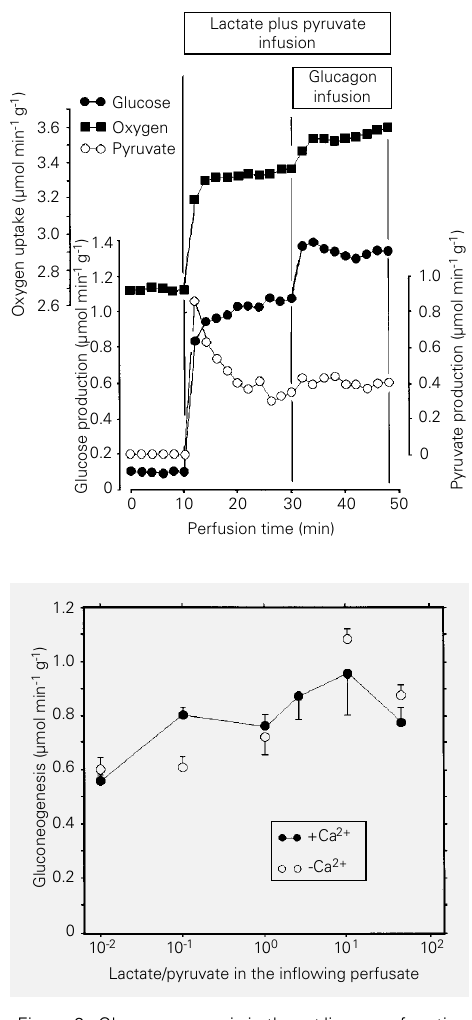
Figure 2 - Gluconeogenesis in the rat liver as a function of the lactate to pyruvate ratio in the presence (filled circles) and absence (open circles) of Ca 2+ . Livers from fasted rats were perfused as described in Material and Methods. The experiments were performed according to the experimental protocol illustrated in Figure 1. The control experiments (filled circles) were performed with Krebs/Henseleit-bicarbonate buffer containing 2.5 mM CaCl 2 . In the Ca 2+ -free experiments (open circles), CaCl 2 was omitted from the perfusion fluid and the intracellular Ca 2+ pools were previously exhausted by repeated phenylephrine infusion in the presence of 0.2 mM EDTA. Initially substrate-free perfusion was performed. The infusion of lactate and pyruvate was initiated after oxygen uptake stabilization. The lactate to pyruvate ratio was changed from 0.01 to 100, with a total lactate plus pyruvate concentration of 3.75 mM. Gluconeogenesis represents the final steady-state rate of glucose release by the liver after 20 min of lactate + pyruvate infusion. Each data point represents the mean of 3 to 5 liver perfusion experiments. The vertical bars represent the standard errors of the